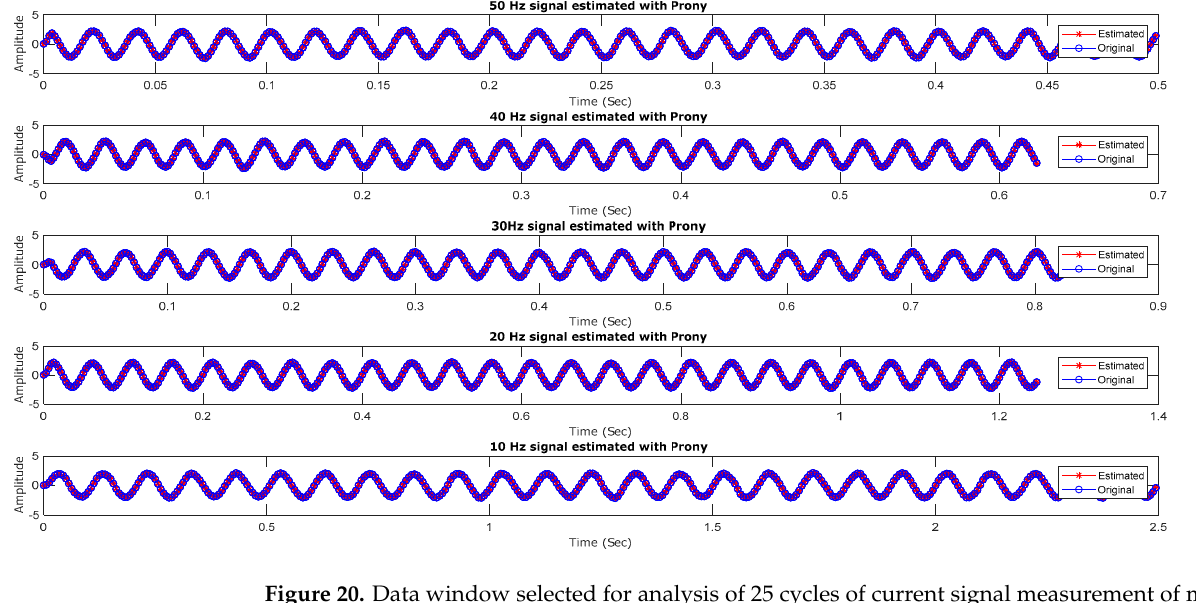
Figure 20. Data window selected for analysis of 25 cycles of current signal measurement of motor line current of phase A at VFD operation frequencies of 50 Hz, 40 Hz, 30 Hz, 20 Hz, and 10 Hz (Prony estimated and original signal). Table 7. Measured current signal estimated parameters (VFD, motor at full